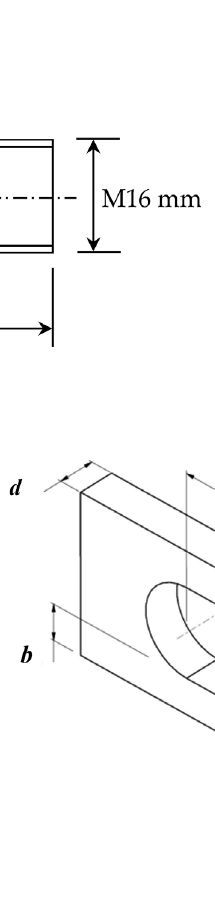
Figure 4: TBS geometry and